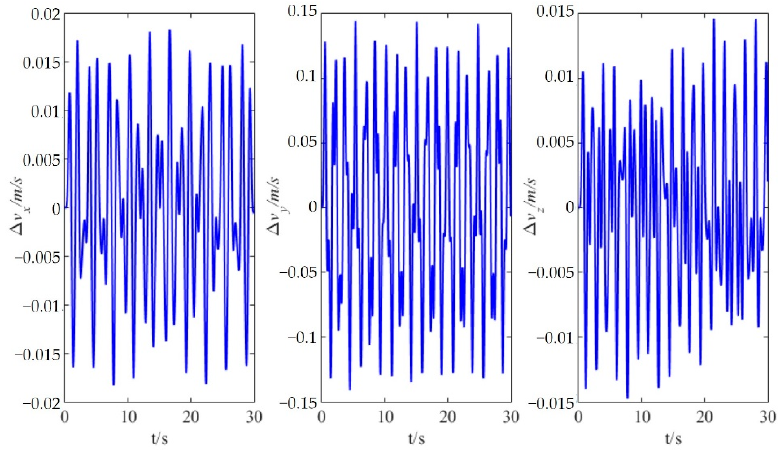
Figure 17. Shearer SINS sculling error.